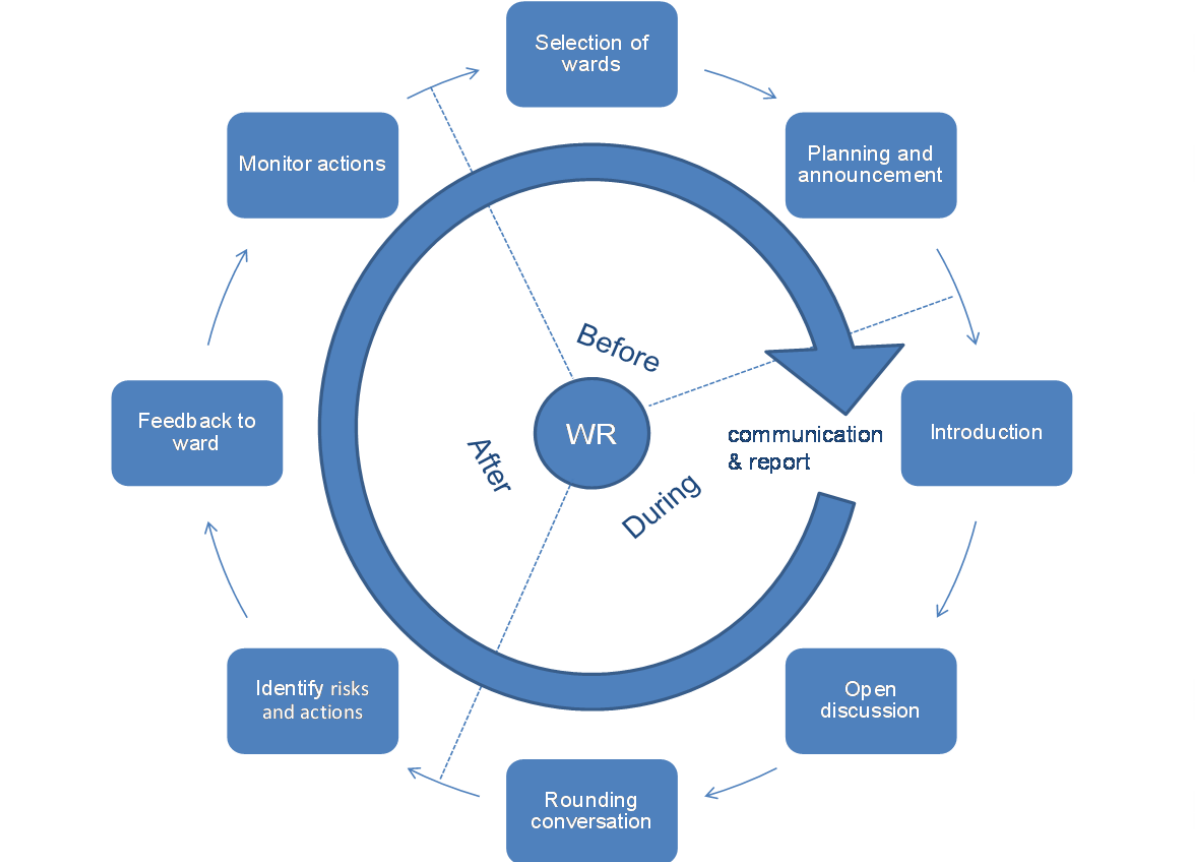
Figure 1. Phases during the